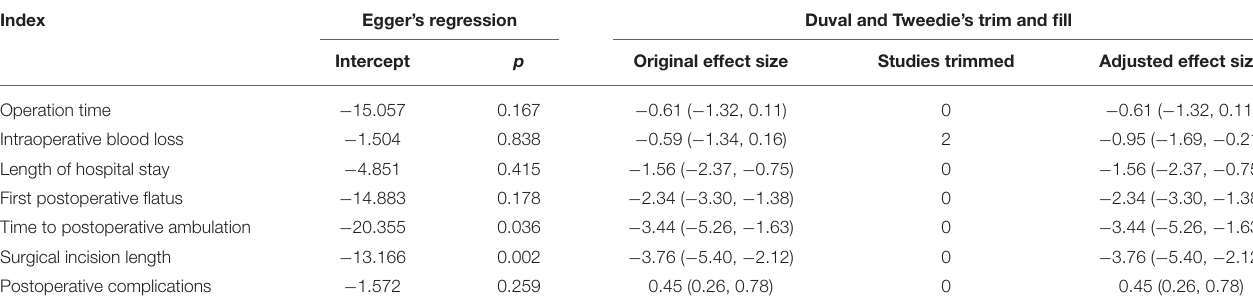
TABLE 3 | Evaluation of publication bias and sensitivity